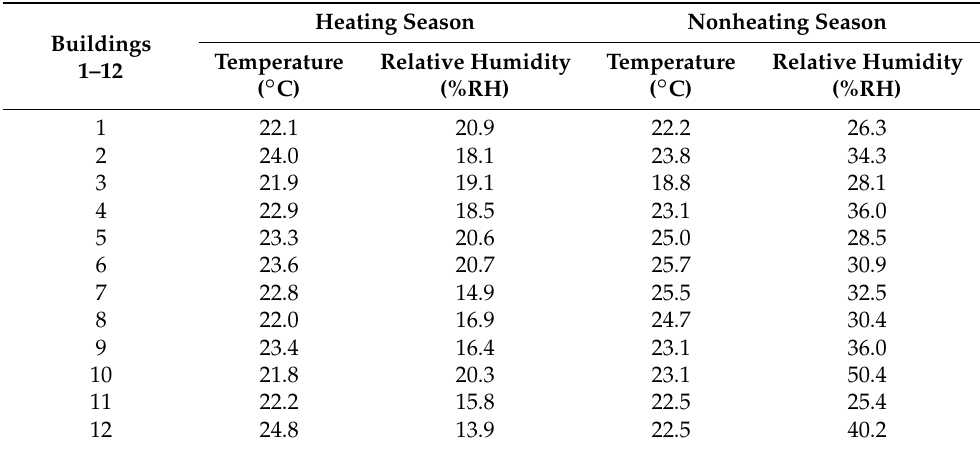
Table A1. Average temperature and average relative humidity in the air samples measured in the twelve office buildings during the heating and nonheating seasons.